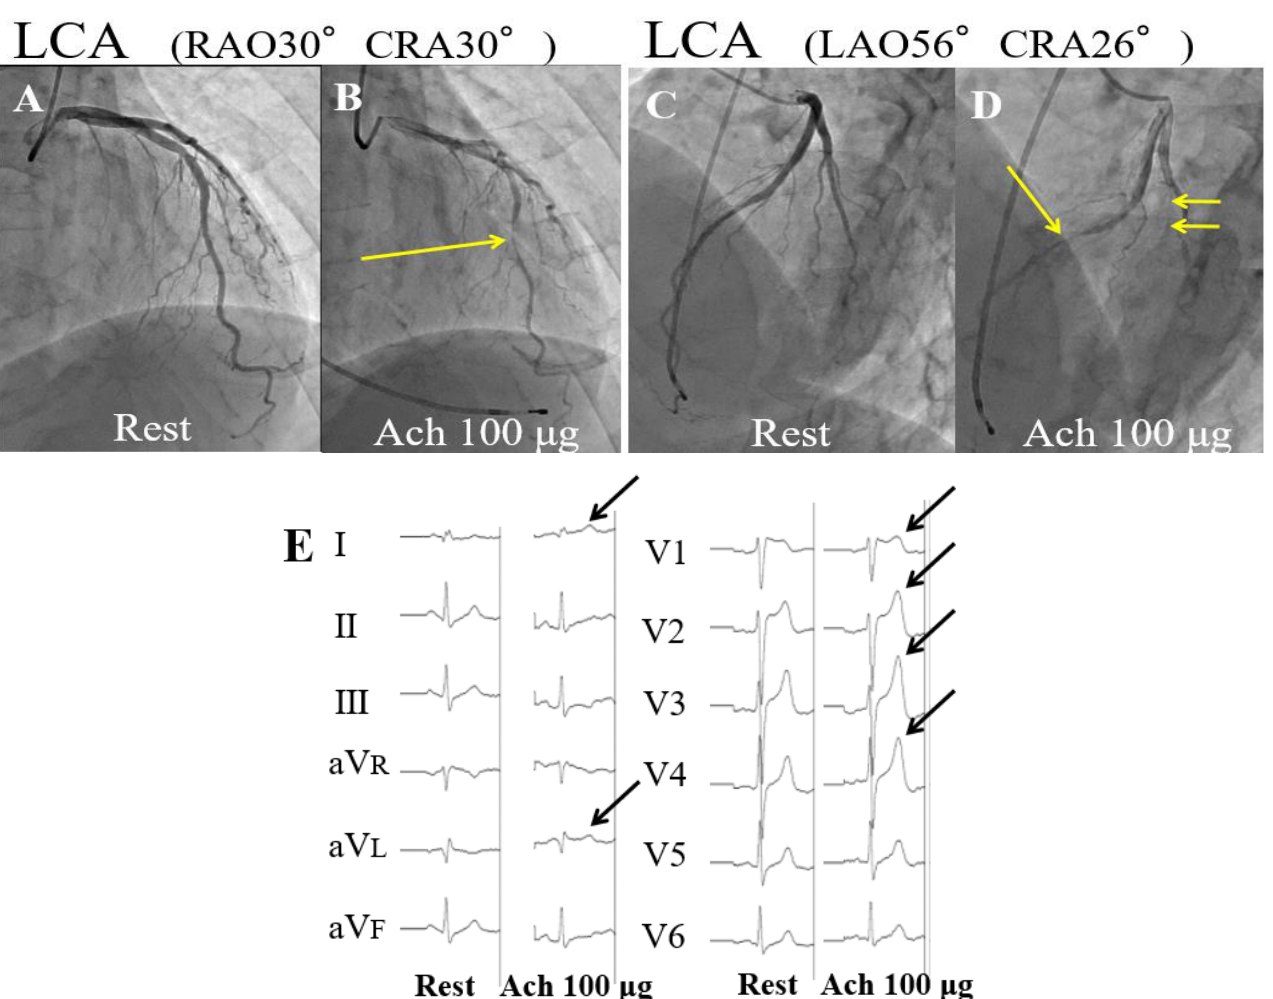
Figure 1. ( A , C ): Coronary angiography (CAG) revealed a nonobstructive coronary artery on admis- sion. ( B , D ): An acetylcholine (Ach) provocation test revealed multivessel vasospasm (left coronary artery (LCA) segments, #7 99% stenosis and #12 total occlusion (yellow arrows) at 100 µg dose into LCA). ( E ): An electrocardiogram showed ST elevation in leads I, aVL, and large T wave in leads V1 – V4 (black arrows) during the Ach provocation test.